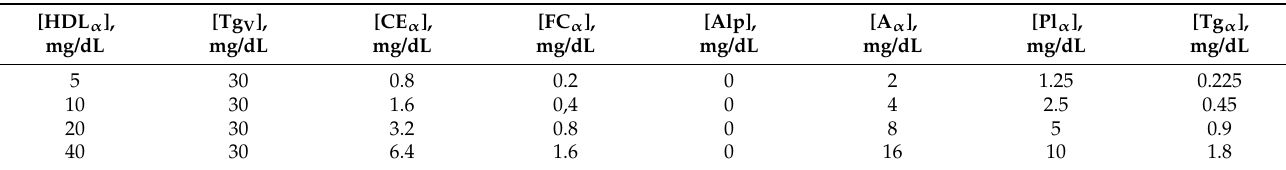
Table 5. Initial concentrations of lipoprotein components.